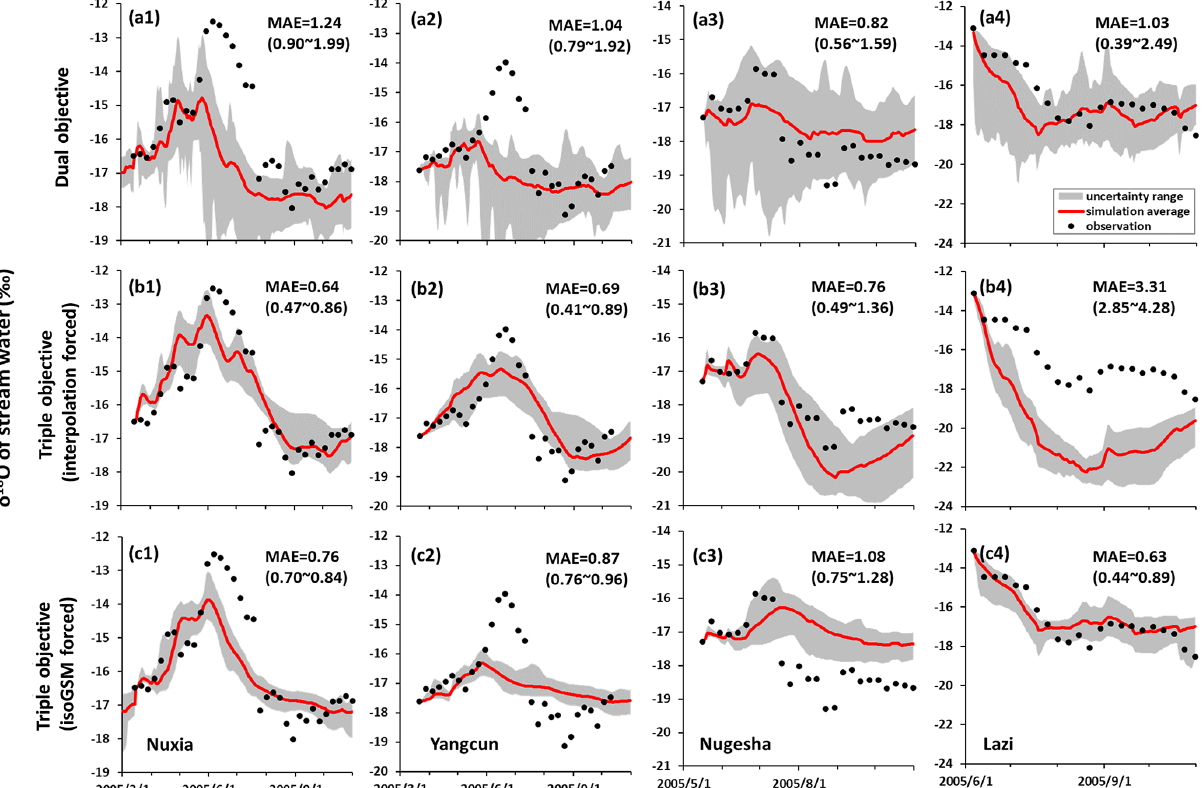
Figure 7. Uncertainty ranges of stream water δ 18 O simulations at four stations in 2005 produced by the behavioral parameter sets of the dual-objective (a) , interpolation-forced triple-objective (b) and isoGSM-forced triple-objective (c) calibration variants. Table 4. Comparisons of the model performance in the KR catchment produced by different calibration variants. Calibration variant Behavioral ratio Period NSE dis RMSE SCA MAE iso Dual objective Triple objective